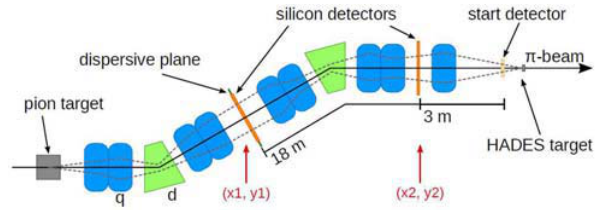
Figure 11. Pion beam line from the production point (pion tar- get) to the HADES target position. Quadrupole and dipole mag- nets guide the pions (the dashed line) through the in-beam track- ing detectors (indicated by the